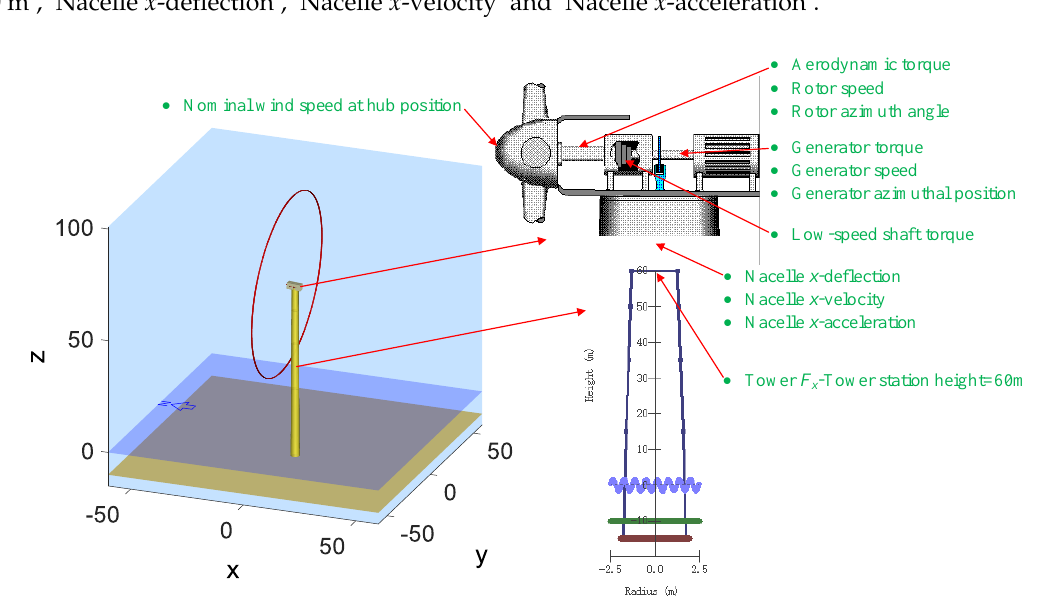
Table 3. Mutual information (MI) values of two-mass model under different wind scenarios. Scenarios